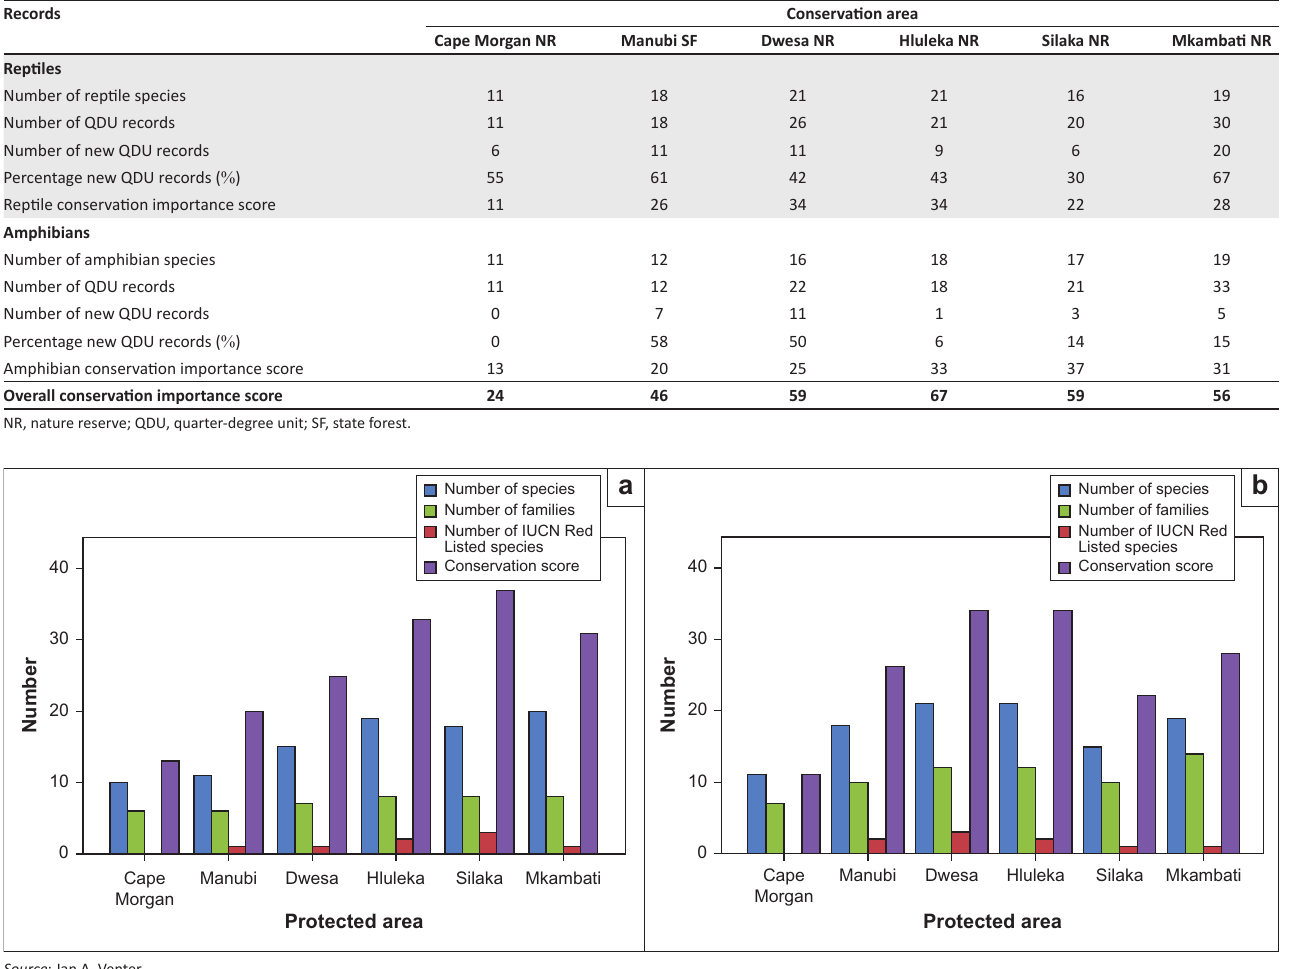
TABLE 3: New quarter-degree-unit records for South Africa and conservation importance score of six conservation areas studied along the Wild Coast, Eastern Cape, South Africa.